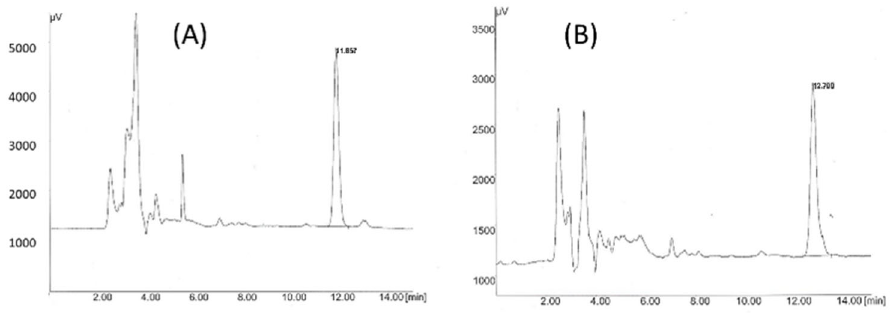
Figure 3. Chromatograms of diazepam ( A ) and midazolam ( B ) at 1.5 µ g/mL. Retention times were 11.9 and 12.7 min, respectively.